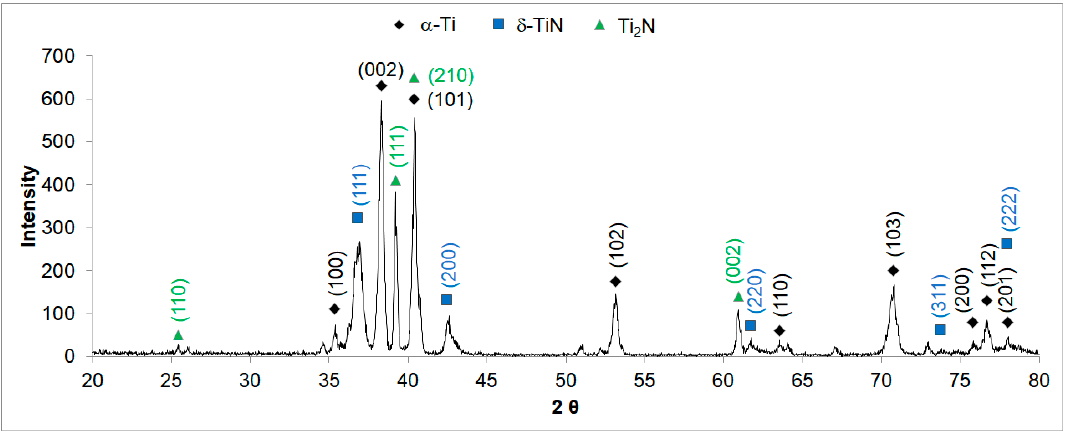
Figure 8. XRD pattern of plasma-nitrided Ti-6Al-4V alloy.